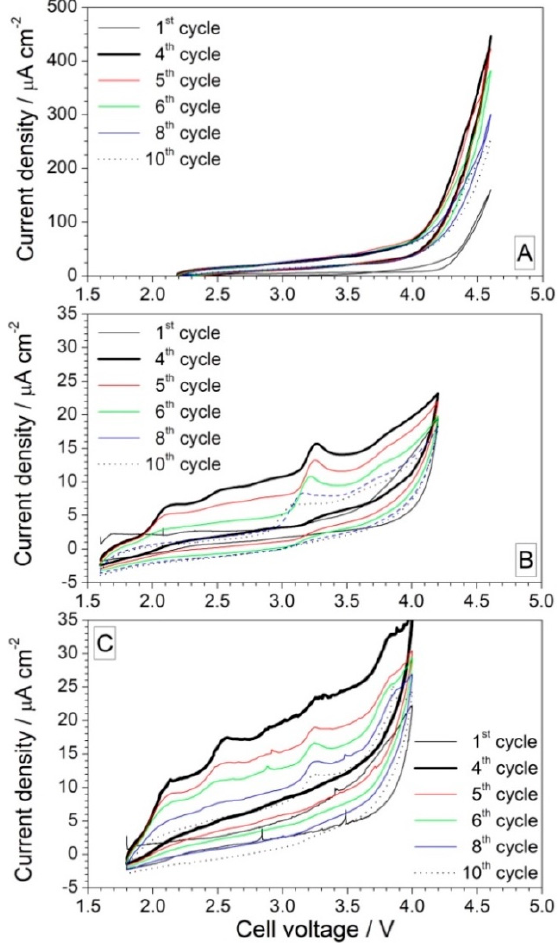
Figure 3. Current-voltage profiles obtained by anodic CV measurements run on Na/0.9EMITFSI- 0.1NaClO 4 /C cells in the presence of moisture contaminations at different anodic cut-offs: 4.6 V (panel ( A )), 4.2 V (panel ( B )) and 4.0 V (panel ( C )). Scan rate: 1 mV s − 1 . Temperature: 20 ◦ C. The voltage values are referred to the Na + /Na ◦ redox couple.